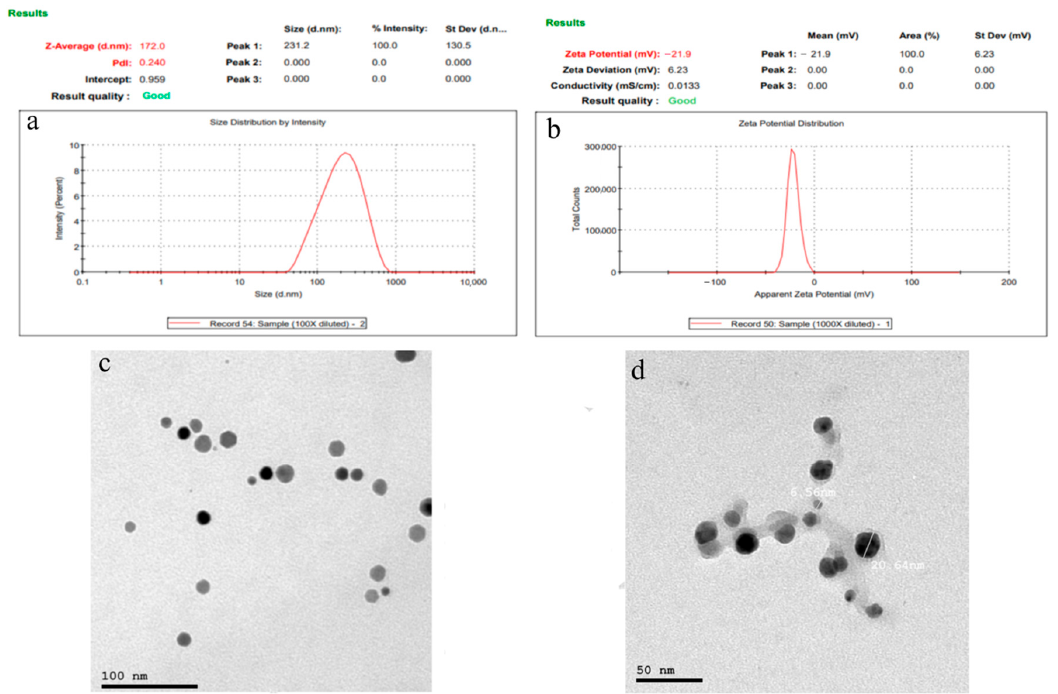
Figure 3. ( a ) Particle size (nm), ( b ) zeta potential (mV), ( c ) Scanning electron microscopy (SEM) (nm) and ( d ) Transmission electron microscopy (TEM) (nm) micrographs of PPEE-SLNs.